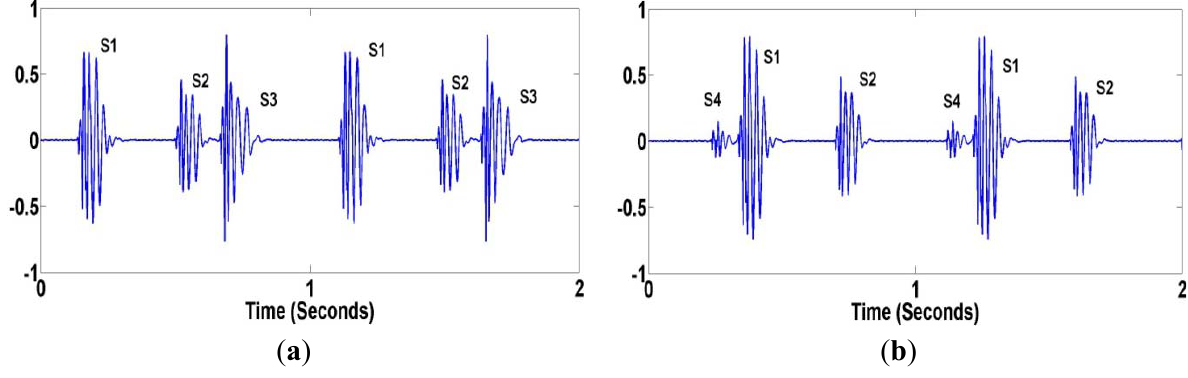
Figure 4 . Abnormal Heart Sounds ( a ) S3; ( b )